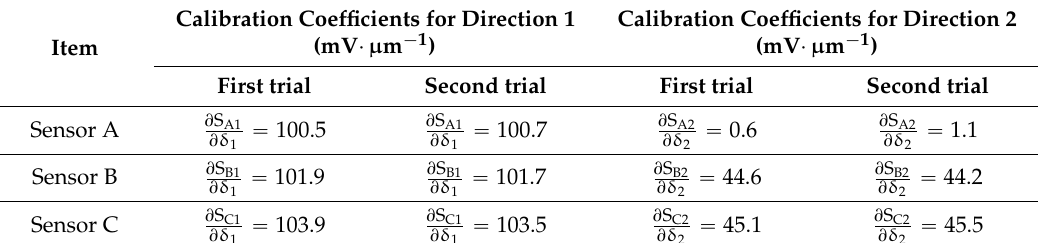
Table 2. Sensitivity coefficients of the three capacitive sensors at the probe tip for displacement in z( δ 1 ) and y( δ 2 ) directions, before and after switching between flexible and stiff operating